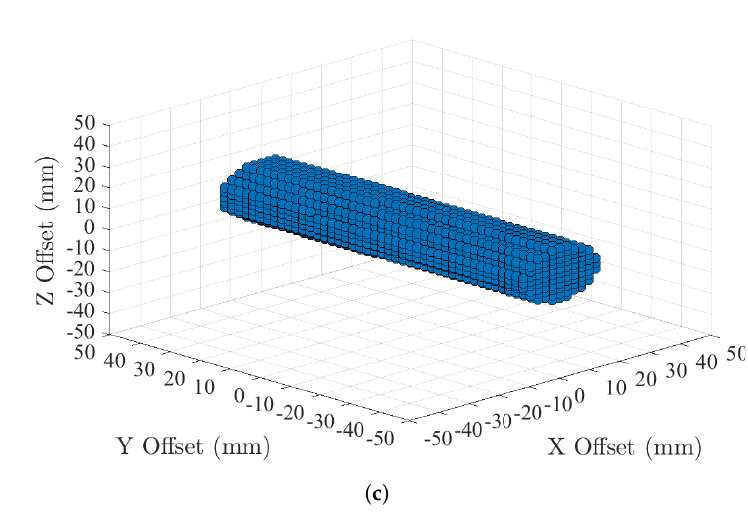
Figure 10. Simulated quiet zone for 25dBi source antenna at ( a ) 75, ( b ) 95 and ( c ) 115GHz.